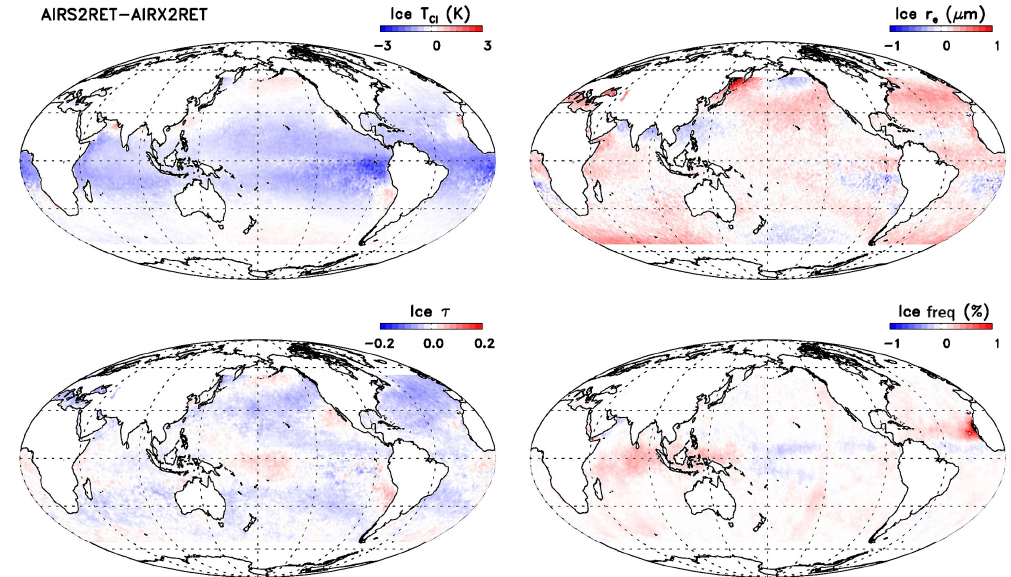
Figure A1. The differences in IR only (AIRS2RET) minus IR/MW (AIRX2RET) for the same time period as described in Fig. 1 for T ci , r ei , τ i , and ice cloud frequency. Note that the minimum and maximum differences may exceed those indicated in the colour